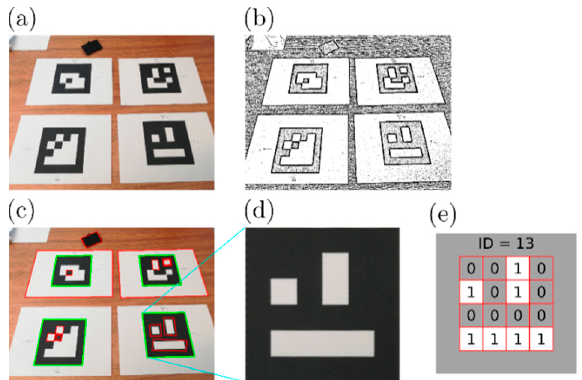
Figure 3. Marker detection process. ( a ) Original frame. ( b ) Results of thresholding. ( c ) Contours detection; in green, the squares that will be identified as markers are shown, in red, instead, all the rejected squares. ( d ) Prospective removal. ( e ) Identification from binary. Algorithm 1: Automatic marker detection and localization algorithm while Frame of the video is available do begin Automatic Markers Detection